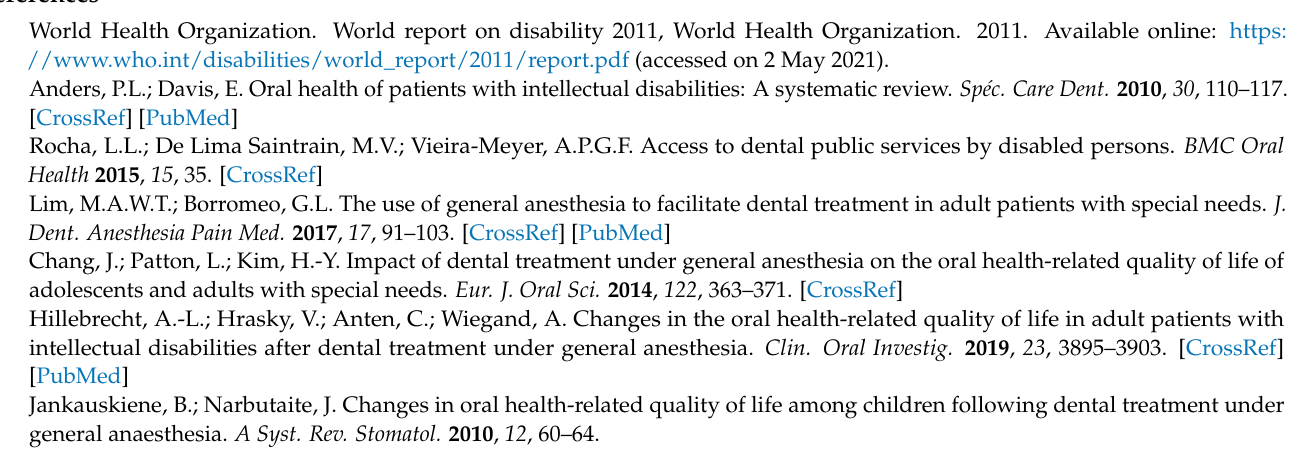
Table S4: Cox regression hazard ratio analysis: univariable and multivariable model of endodontic re-treatment; Table S5: Cox regression hazard ratio analysis: univariable and multivariable model of